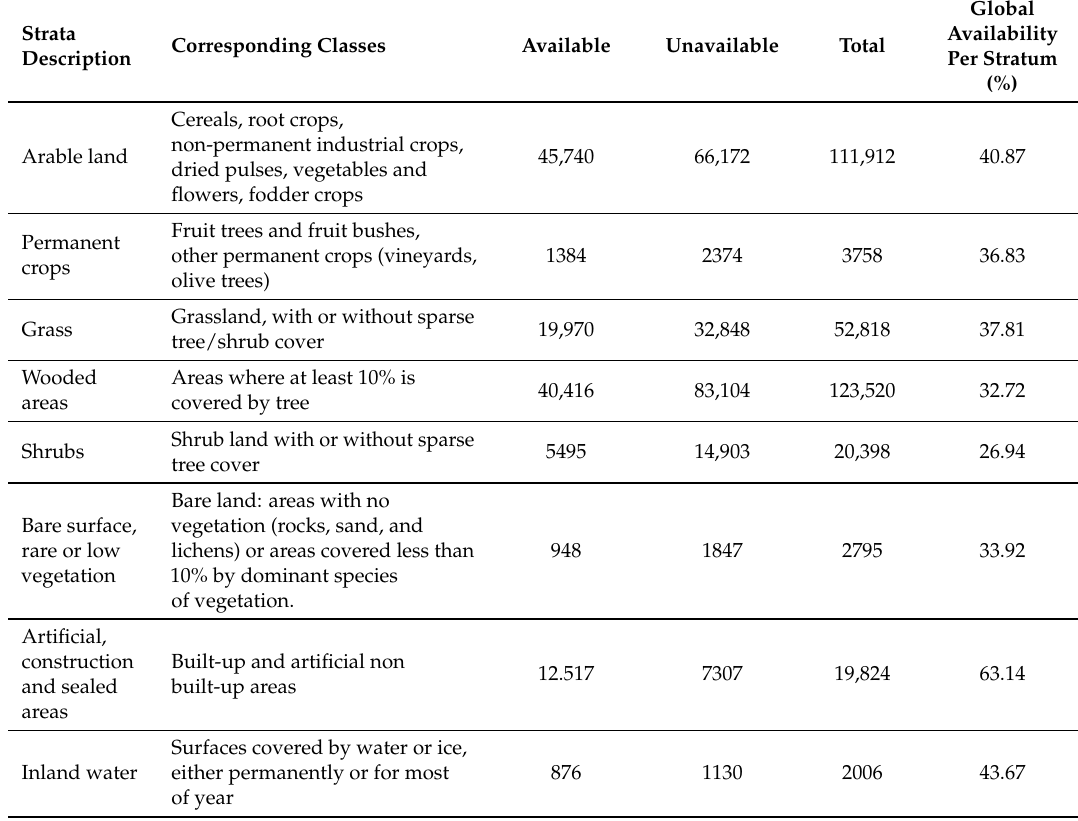
Table 3. Availability of crowdsourced imagery based on the LUCAS sampling for 8 main land cover